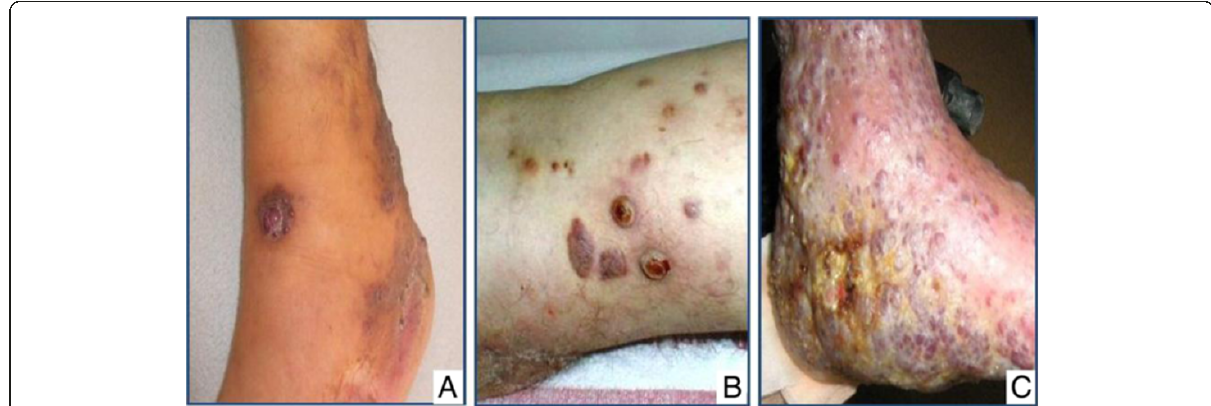
Figure 1 Different clinical appearances of lesions in bullous KS: (A) focal vesiculobullous changes in lesions of plaque and nodular stage, (B) bulla structures showing ulceration in nodular stage lesions, (C) sponge-like vesiculobullous lesions in a generalized KS case are observed.